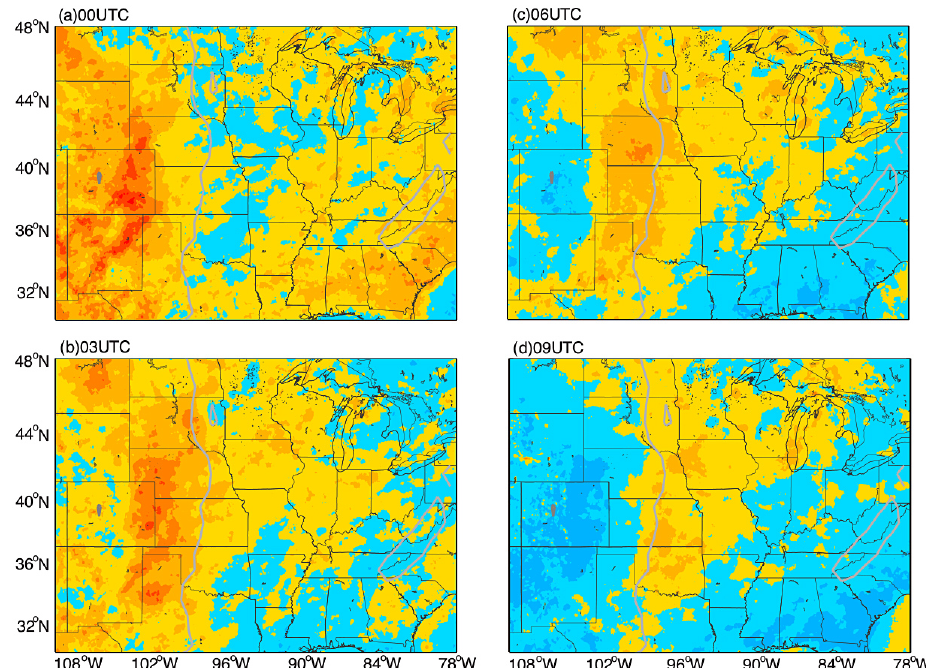
Figure 4a. Similar to Fig. 3 but normalized hourly mean precipitation over North America from 00:00 to 09:00UTC (a–d) . The darker gray line represents terrain elevation of 3000m and the lighter one is 500m.